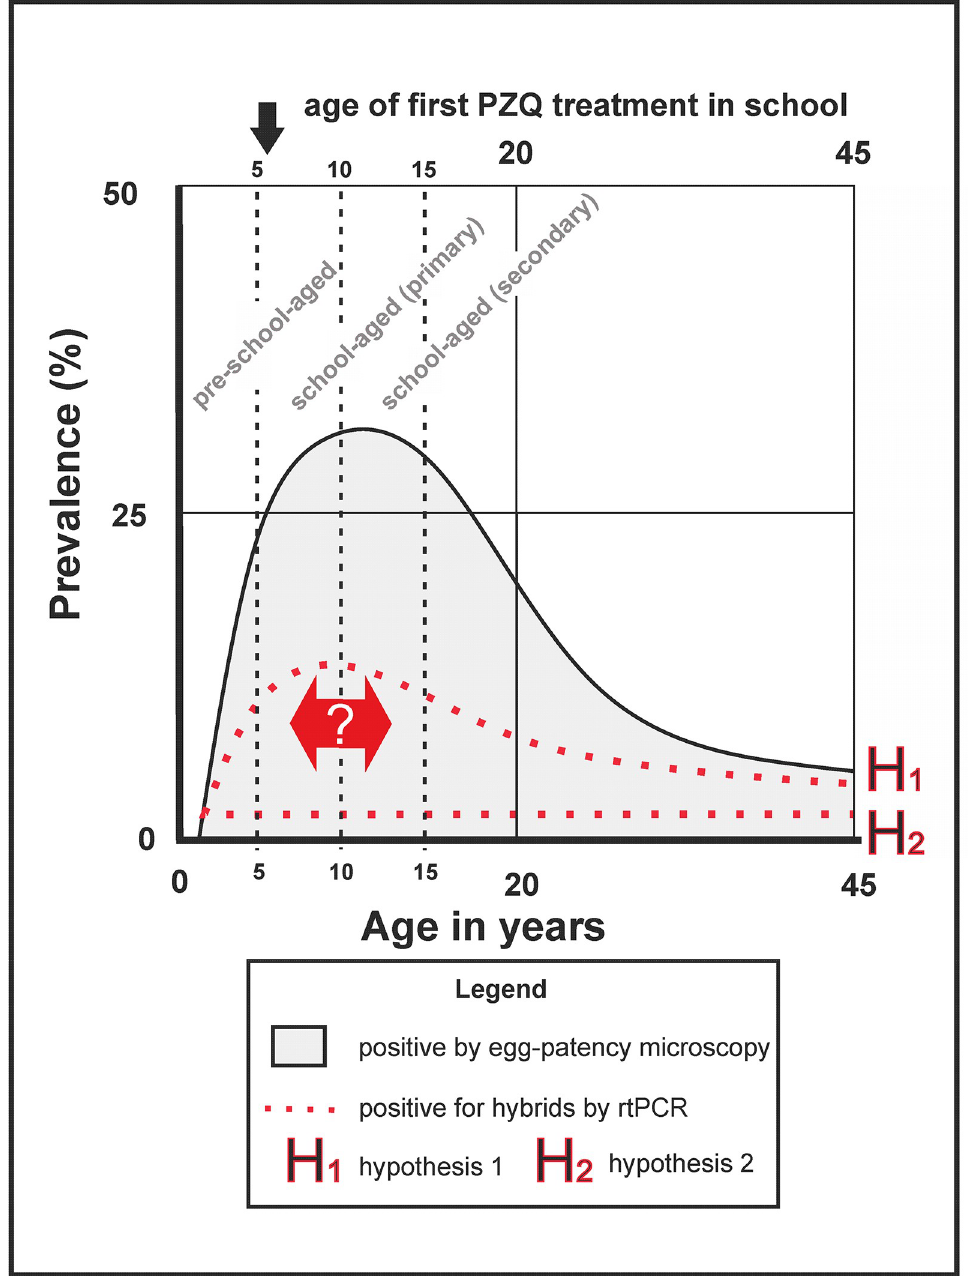
Fig 2. Highlighting knowledge gaps in the epidemiology and distribution of hybrid coinfections across a “typical’ community as current age-prevalence profiles are not known. This hypothetical scenario raises important epidemiological questions in the short- and long-term infection dynamics and needs for any future targeting of preventive chemotherapy control to any specific demographic groups (e.g., preschool-aged children) where hybrids may be, for example, more common. PZQ treatment campaigns typically commence in primary school, where the youngest children to receive treatment are usually older than five years of age. Thereafter, provision of PZQ treatment then follows either annual or biennial administration cycles. PZQ,